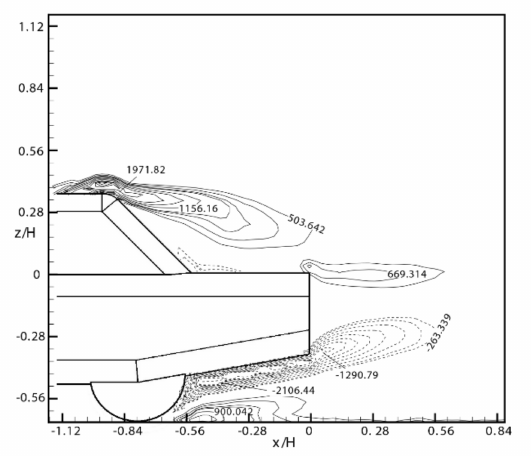
Figure 17. Iso-contours of time-averaged streamwise vorticity ω y in x–z plane at y/H = 0.28. Minimum and incremental values of vorticity are ω y,min = − 263.339 s − 1 , 503.642 s − 1 , and − 1 , ∆ ω y = 188.227 s